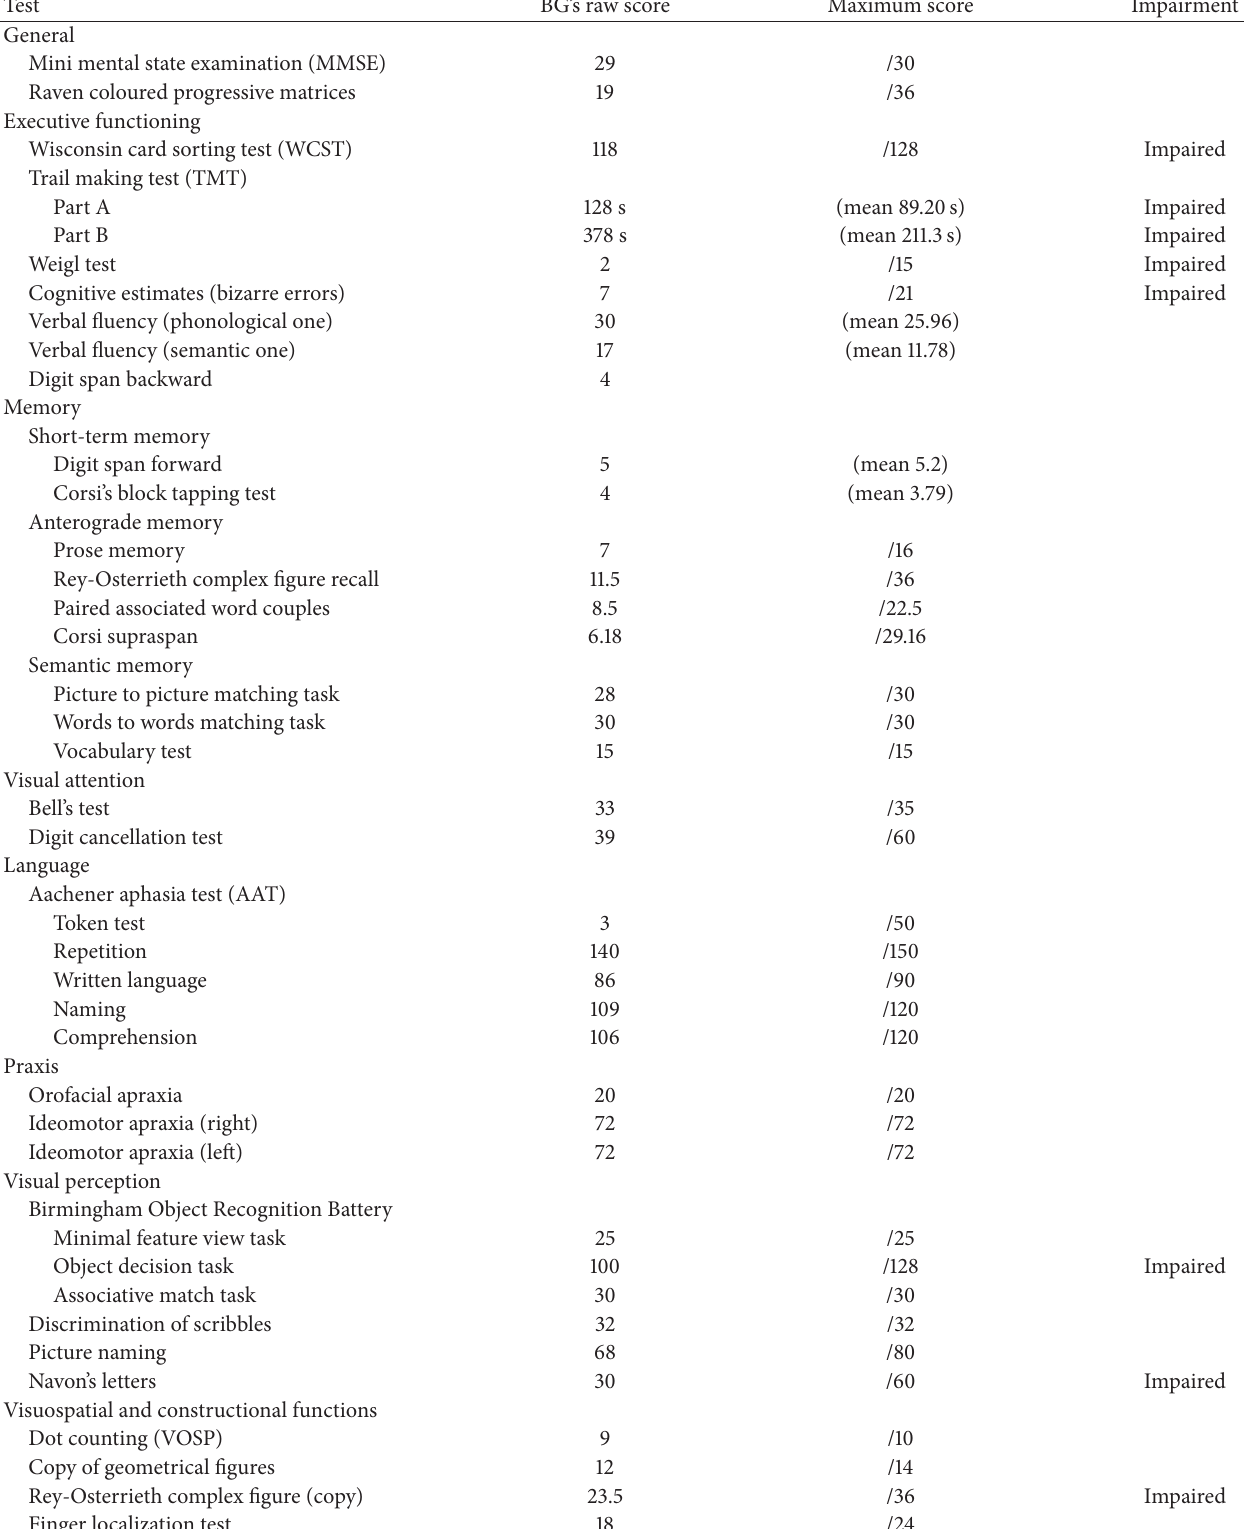
Table 3: Neuropsychological test